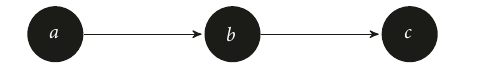
Figure 1: Argumentation framework 𝐴𝐹 = ( A , R ) with A = {𝑎,𝑏, 𝑐} and R = {(𝑎,𝑏),(𝑏, 𝑐)} . The labeling {{𝑏},{𝑐},{𝑎}} is conflict- free; {{𝑎,𝑐},{𝑏}, 0} is the only complete